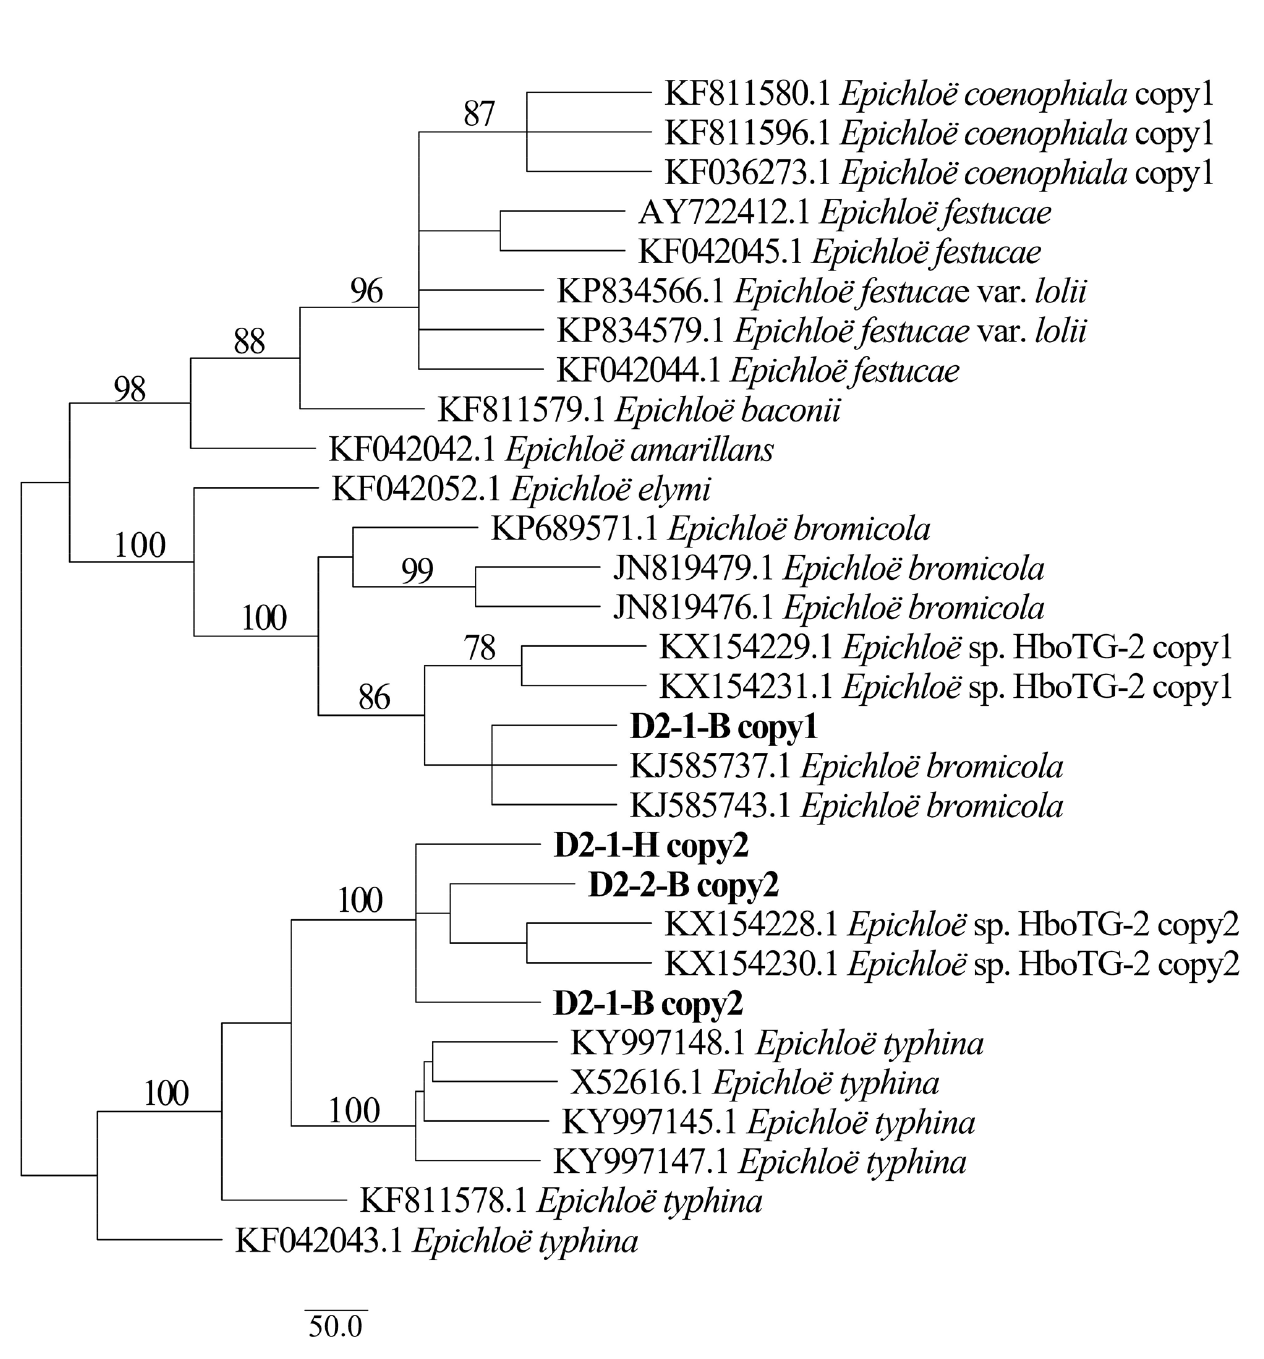
Figure 6. Phylogeny derived from maximum parsimony (MP) analysis of the tubB gene from representative Epichloë species and copies of the hybridized endophytes isolated from H. bogdanii